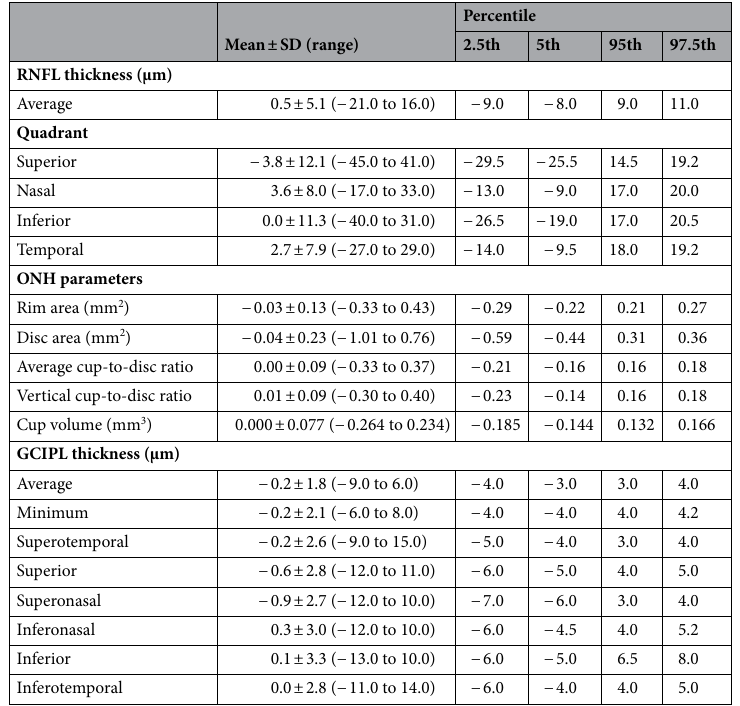
Table 2. Percentile distribution of interocular differences (right eye–left eye) in optical coherence tomography parameters between the right and left eyes (n = 310). RNFL retinal nerve fiber layer, ONH optic nerve head, GCIPL ganglion cell-inner plexiform layer.